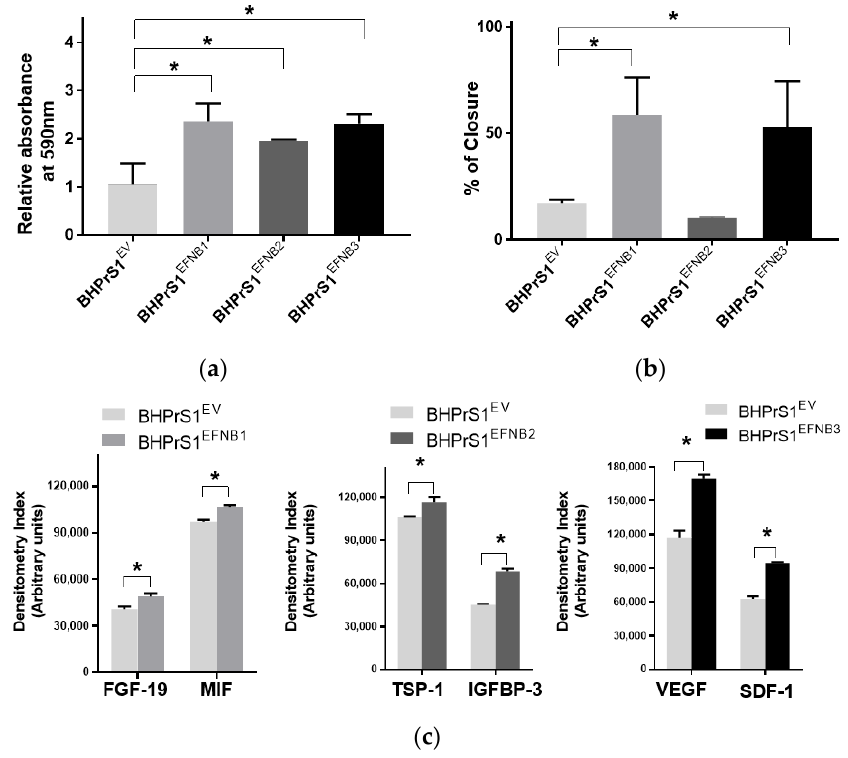
Figure 3. Paracrine signals from Ephrin B-engineered BHPrS1 cells regulate BPH1 cell proliferation and migration. ( a ) BPH1 cell proliferation cultured in the presence of Ephrin B expressing BHPrS1 conditioned media (BHPrS1 EFNB1 , BHPrS1 EFNB2 , BHPrS1 EFNB3 ) and compared with control cells (BHPrS1 EV ). One-way ANOVA with Dunnett multiple comparison tests indicate that BPH1 exposed